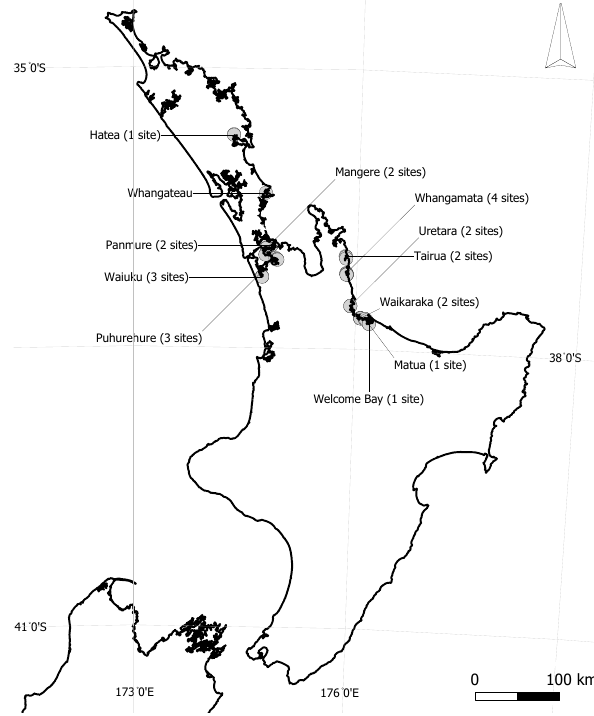
Figure 1. Location of the cleared mangrove sites ( • ) and estuary locations throughout the North Island, New